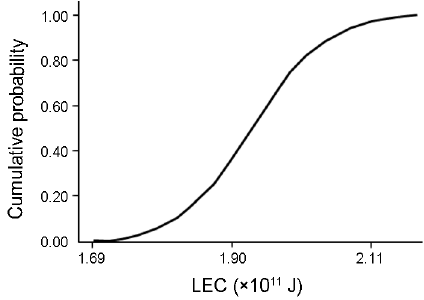
Fig. 15. Lifecycle energy consumption (Cumulative distribution function)